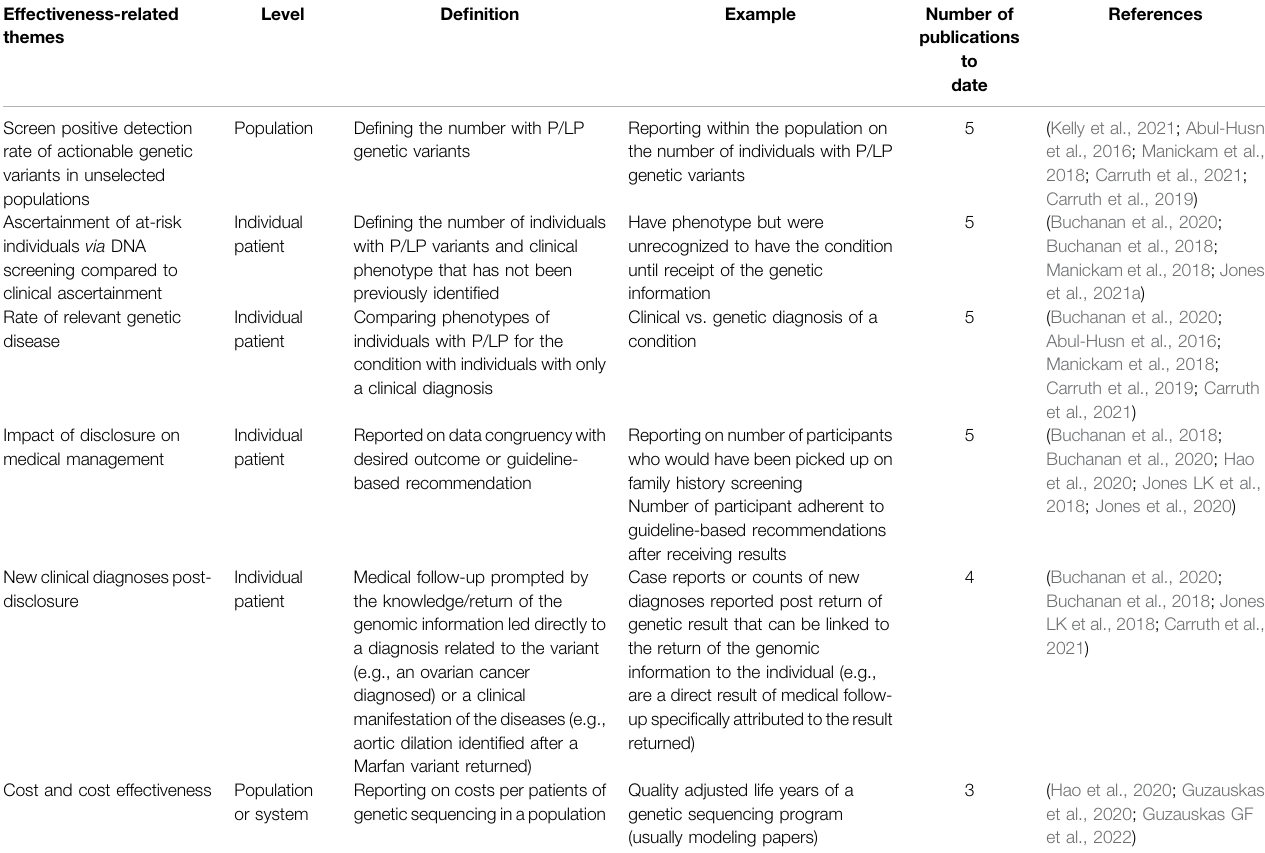
TABLE 4 | Program review effectiveness construct results reported by clinical utility-associated thematic